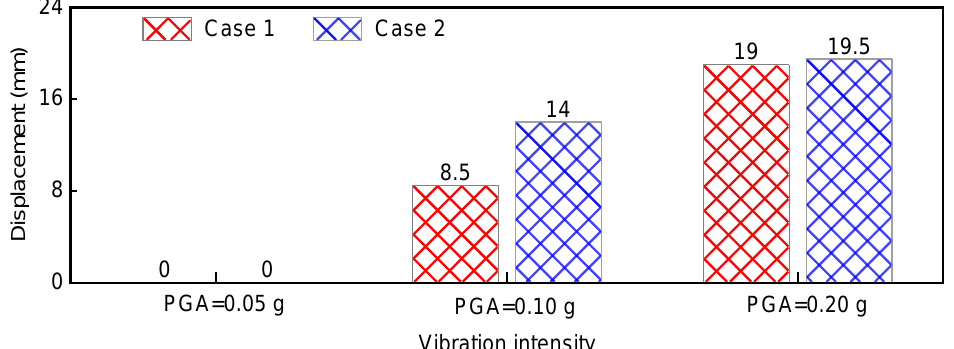
Figure 12. Lateral displacement of the sheet-pile wall.